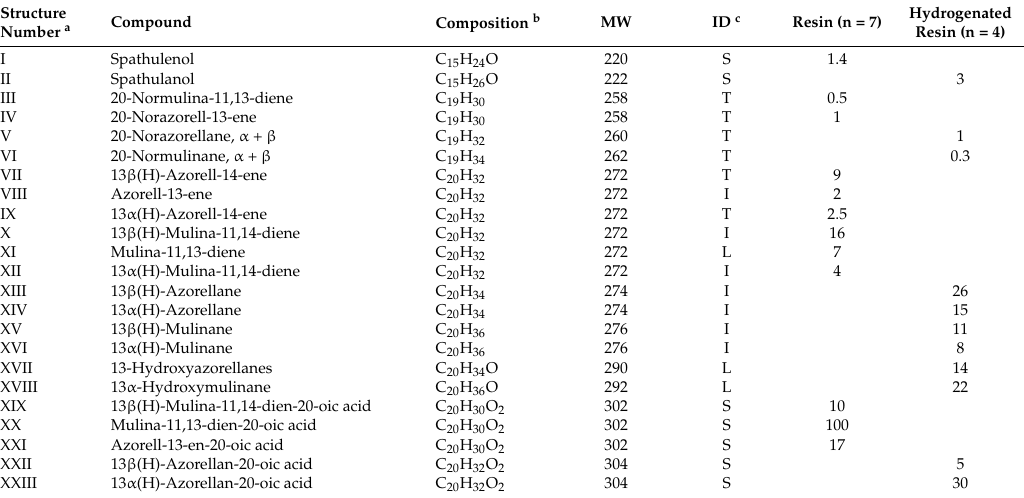
Figure 2. Examples of GC-MS total ion current traces for A. compacta resin and hydrogenated resin analyzed as: ( a , c ) total extracts, and ( b , d ) silylated extracts. Roman numerals refer to structures in Table 1 and Appendix A. Table 1. Relative concentrations of the major compounds identified in resin and hydrogenated resin of Azorella compacta .